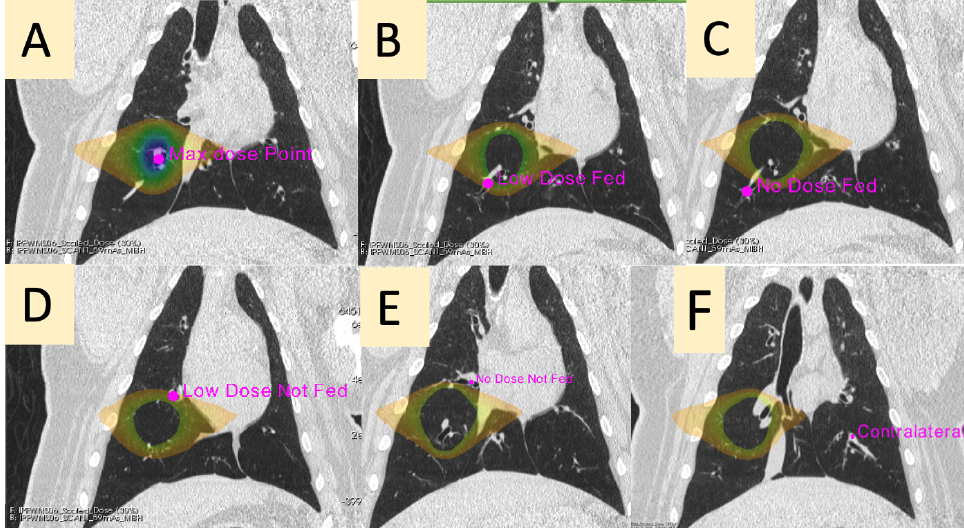
Figure 3. Representative placement of contours analyzed. The point of max dose is shown in the center of the full dose distribution ( A ). The 5–20 Gy dose distribution is shown in ( B – D ) to indicate the region of low dose. A point on the low-dose region fed by the max dose vessel ( B ) and not-fed ( D ) are placed. Points receiving no-dose fed by the max dose vessel and not-fed are placed in ( C , E ), respectively. Finally, a point in the contralateral lung is placed approximately where the max dose is mirrored on the ipsilateral lung ( F